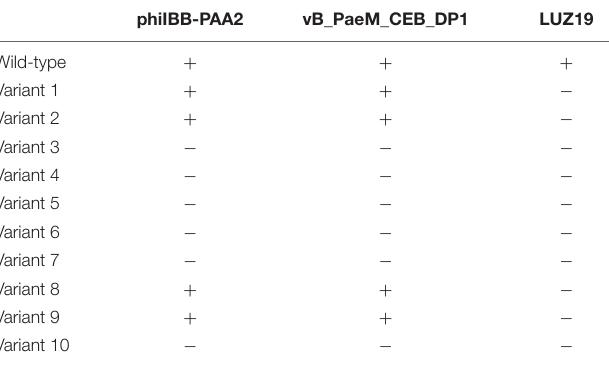
TABLE 1 | Susceptibility of the Pseudomonas aeruginosa PAO1 wild-type and variant strains (1–10) to the phages phiIBB-PAA2, vB_PaeM_CEB_DP1 and LUZ19.